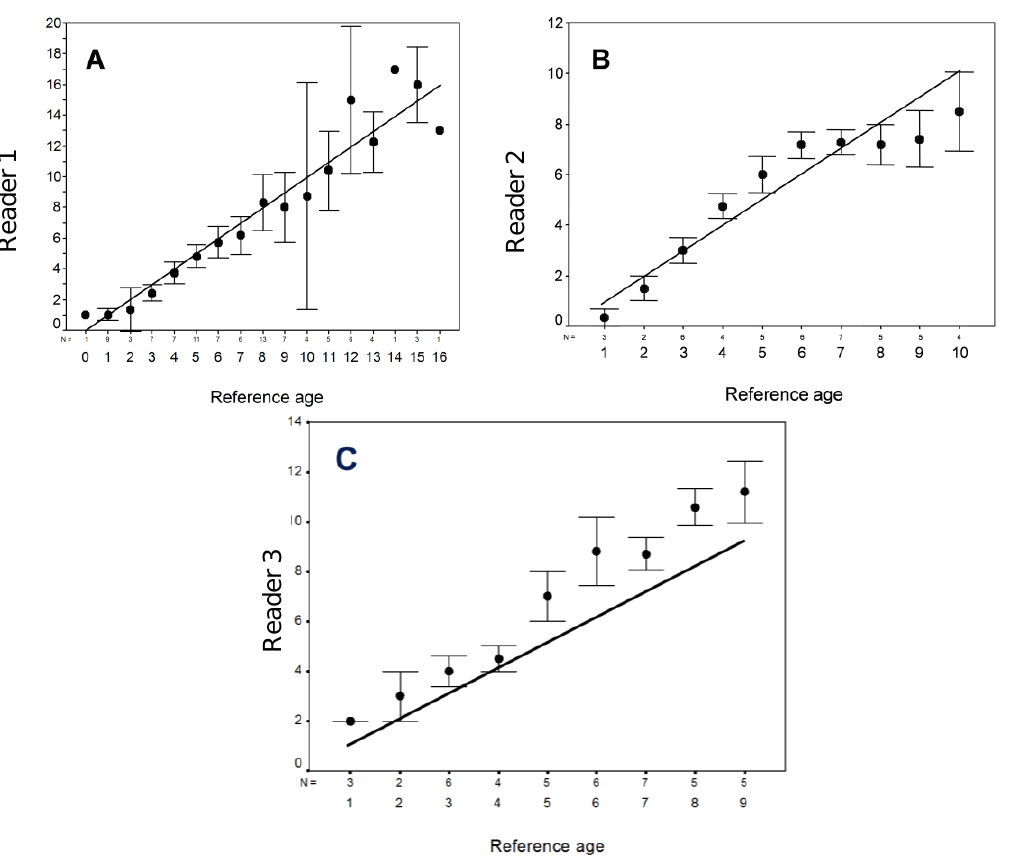
Fig. 3. Examples of age bias plots where no bias is present (A) and where bias is present (B and C). In (B), Reader 2 has over-aged ages 4-6 but under-aged ages 8- 10. In (C), Reader 3 has consistently counted 1-2 extra growth bands compared to the Reference age. Each error bar represents the 95% confidence interval about the mean age assigned to all samples of a given age by a second age reader (Reference age, known or assumed to be correct). The 1:1 equivalence (solid line) is also indicated. Numbers plotted below symbols are the sample size at each